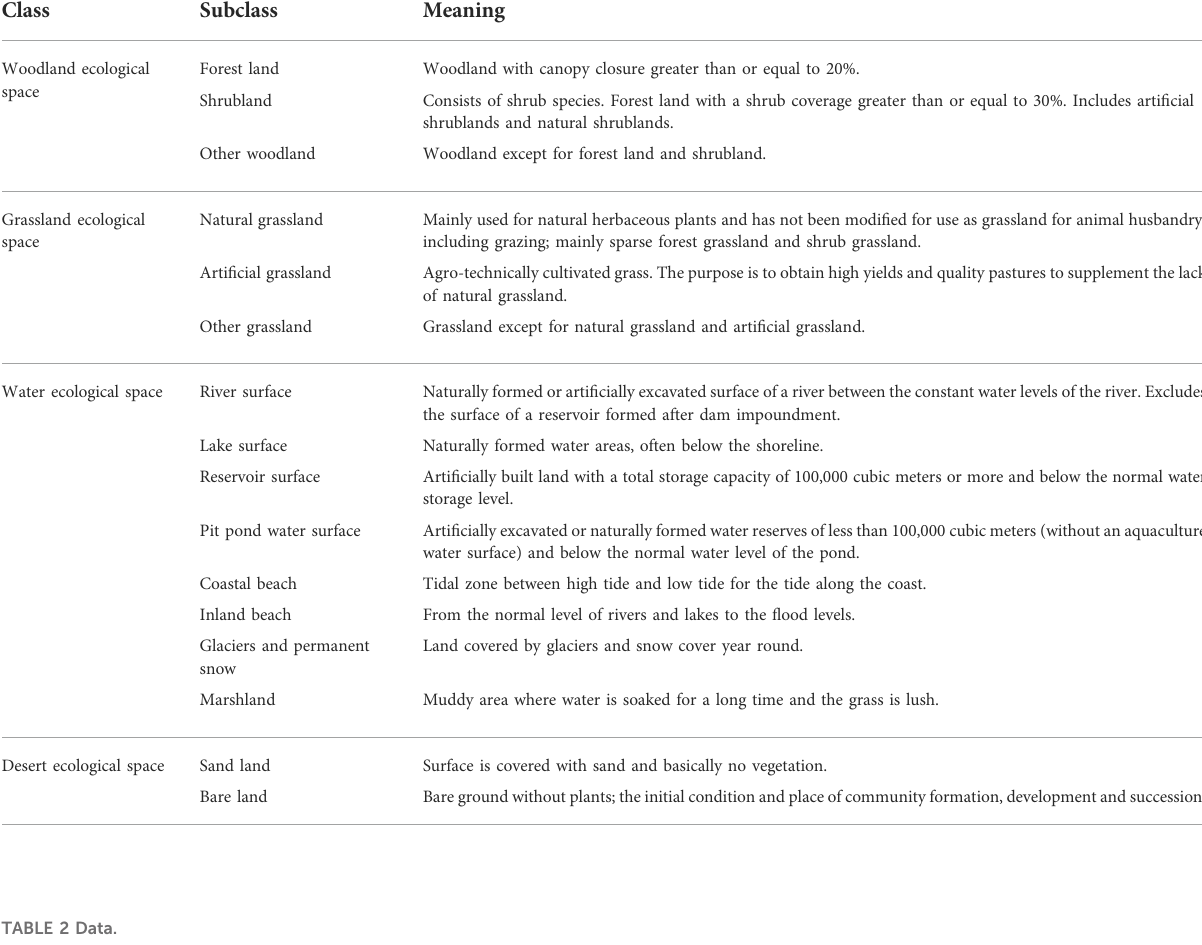
TABLE 1 Ecological space type classi fi cation system based on classi fi cation standards for land status in